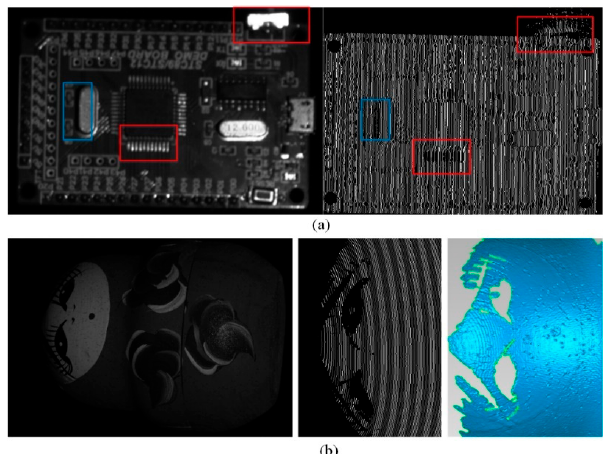
Figure 5. Example of missed detection. ( a ) Specular reflection and geometric occlusion result in missed detection; ( b ) Region with black texture leads to missed detection.